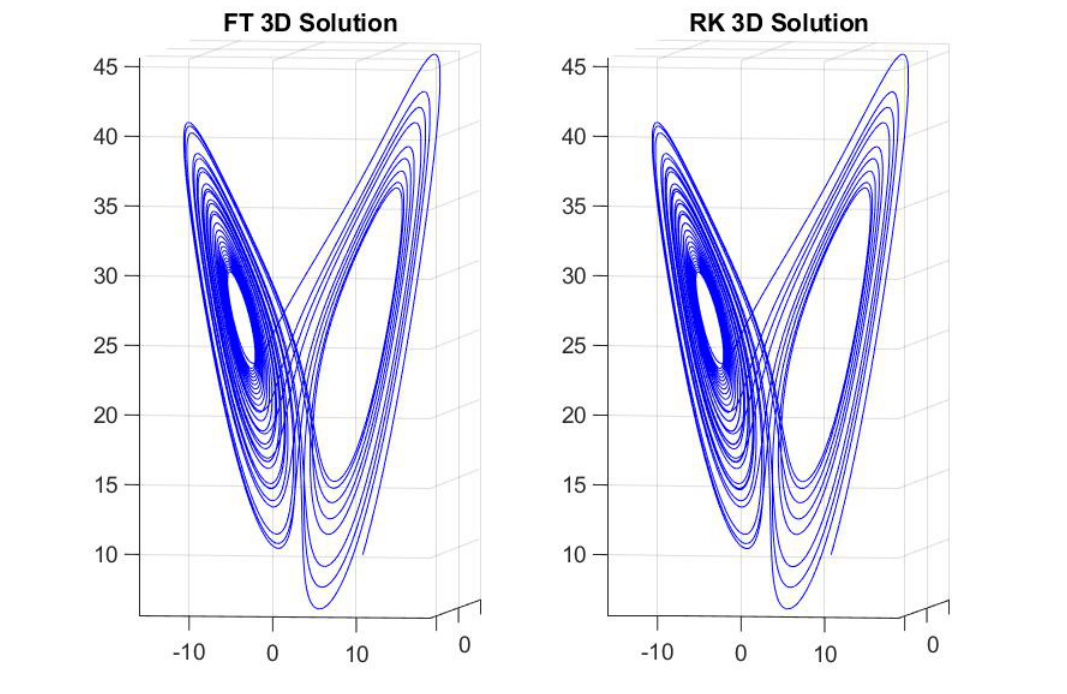
Figure 6. Problem No4 (Lorenz system): 3D representations of the solutions obtained by ODE-FT ( left ) and ode45 ( right ); they appear to be coincident to graphical